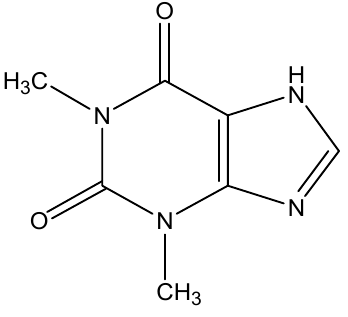
Figure 1. Chemical structure of theophylline.